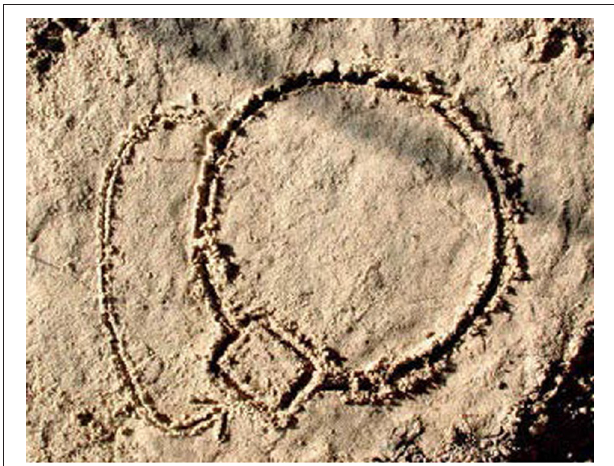
FIGURE 1 | The replicon model. A drawing in the sand (provided by M. Mechali to an EMBO meeting report by Skarstad et al. (2003, Copyright, John Wiley and Sons) to celebrate the 40th anniversary of the